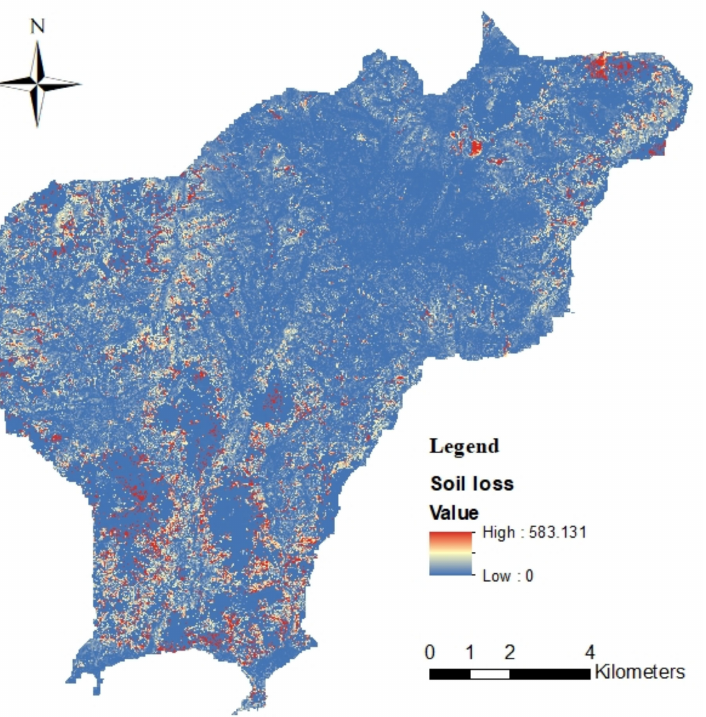
Figure 21. Soil loss map with R-factor values derived from in situ data and C-factor values derived NDVI(vk) data.